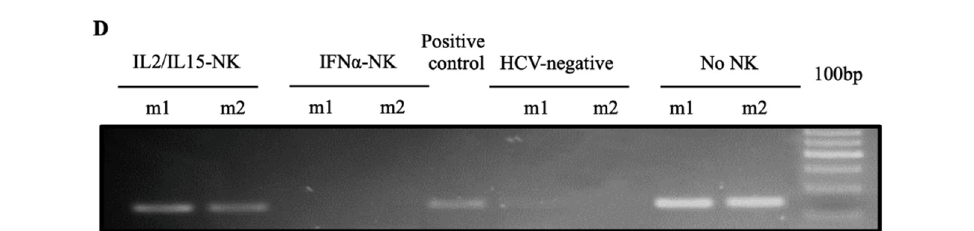
Figure 2. NK cells activated with IFN- α inhibited HCV replication in vivo. ( A ) Weekly HCV viremia levels in human-hepatocyte-engrafted and HCV-infected uPA/SCID mice following treatment with two doses of either IFN α -NKs (lilac dots) or IL2/IL15-NKs (gray dots) or no treatment at all (black dot) (n = 2/group). Each dot represents a mouse. ( B ) Concentrations (mg/mL) of human albumin in mice two weeks ( − 2 wk) or one day ( − 1 d) before NK-cell treatment and three (+3 wk) or six (+6 wk) weeks after NK-cell treatment. Each dot represents a mouse. ( C ) Representative images of immunohistochemical staining of either HCV NS3 or CD56 (brown color) in chimeric livers of untreated mice ( i ), or IL2/IL15-NK- ( ii ) or IFN α -NK-treated ( iii ) mice. Uninfected and untreated mice were used as negative controls ( iv ). Mayer’s hematoxylin (blue/purple color) was used to counterstain the nuclei, facilitating the identification of human hepatocytes (H) within the mouse (M) parenchyma. Magnification of 200 × . ( D ) Representative agarose gel electrophoresis image showing the presence or absence of the HCV intermediate replication product (negative-strand RNA; 150 bp) in mouse livers as in C (m1 and m2 indicate mouse 1 and mouse 2,